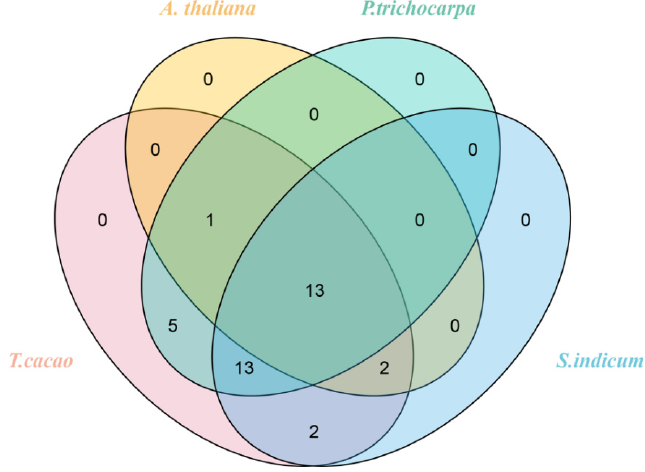
Figure 6. Venn diagram of the identical and different GRAS genes among T. cacao , A. thaliana , P. trichocarpa , and S. indicum .